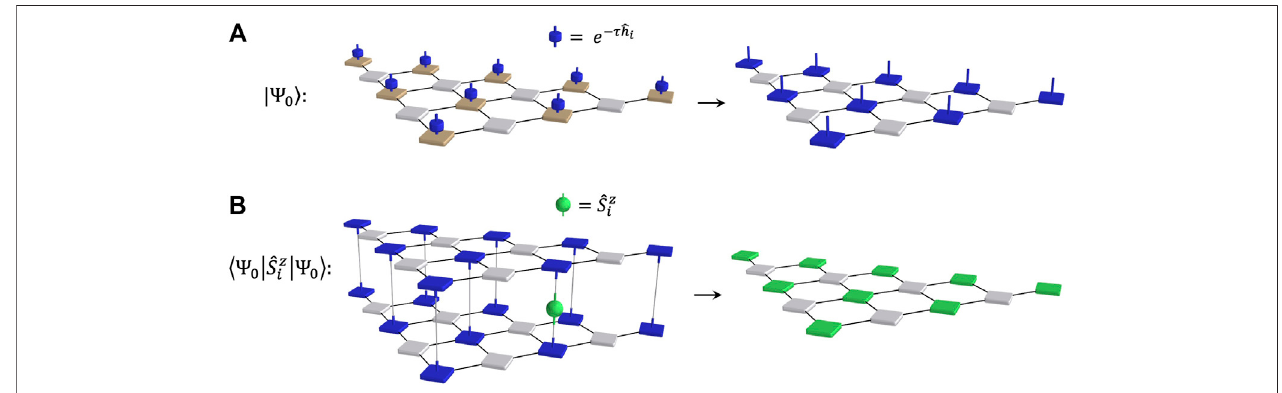
FIGURE4| Theoptimizationprocessusingimaginarytimeevolution(ITE)onthetensornetworkfortheopen-pitminingproblem. (A) TheschematicofITEprocess asdescribedin Eq. 13 .Theleft panelshows theITE process usingthe localevolution gate exp (− τ ^ h i ) with ^ h i (cid:1) w i state, as shown in light brown and grey square de fi ned in Figure 3 . The right panel shows the obtained ground state wavefunction, with each blue block being an updated local tensor. (B) The schematic of measuring a local operator as described in Eq. 14 or Eq. 16 . The operator may change to different form. The left panel shows thetensornetworkconstructionoftheexpectation valuecalculation.Therightpanelshows thescalar tensor networkforthelocalobservation withrenewed local tensors.